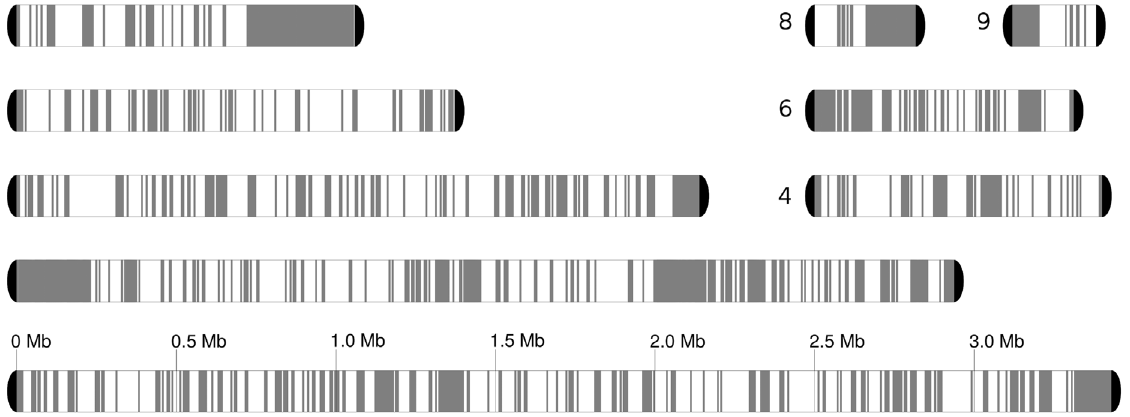
Fig 2. Chromosome blocks for the reference genome, comprising seven chromosomes and two unplaced scaffolds. Heterozygous regions are in white, while homozygous blocks of at least 5 kb are depicted in grey. Loss of heterozygosity (LOH) detection is described in Materials and